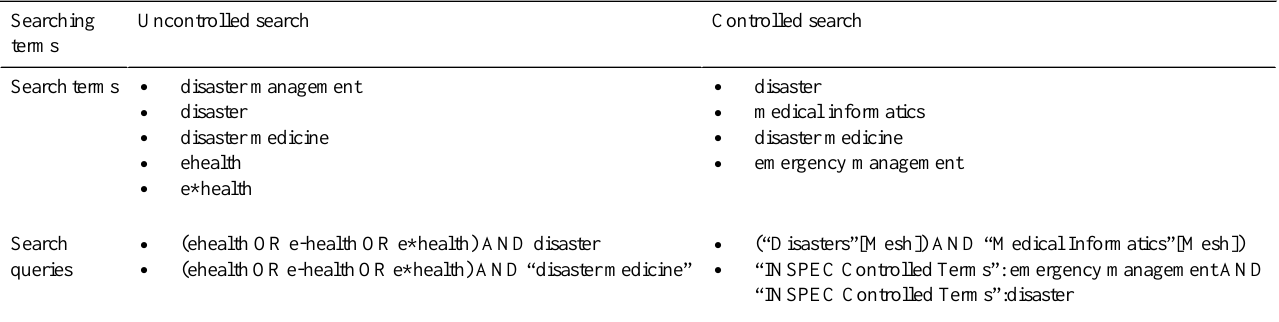
Table 1. A sample of search terms and queries.